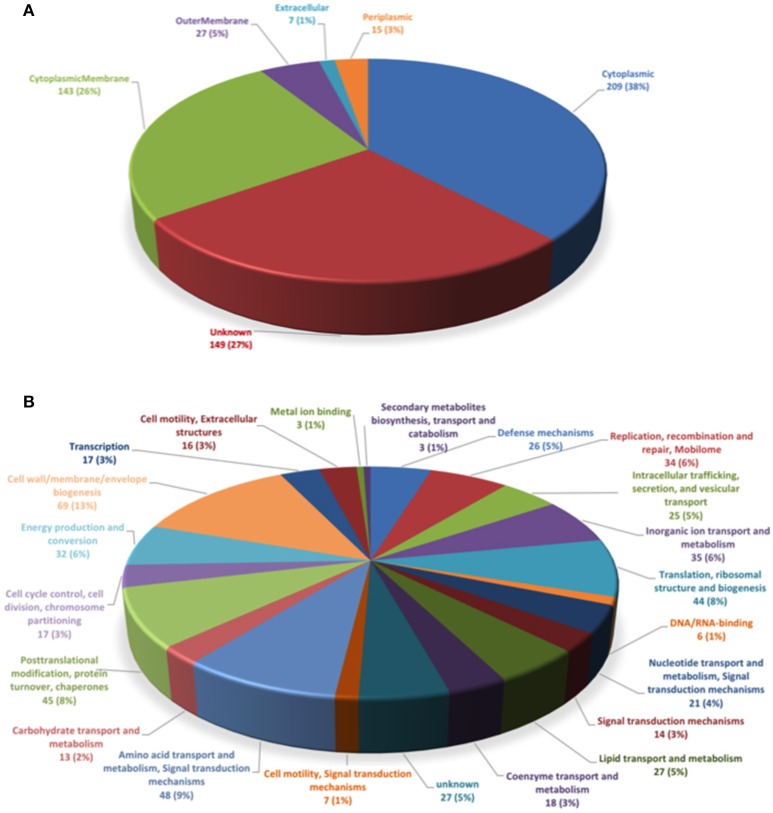
Classification of P. salmonis LF-89 membrane vesicles proteins. (A) Subcellular locations of membrane vesicle proteins identified by MudPIT. Predicted subcellular locations of the 452 membrane vesicle proteins identified using PSORT3b. (B) Functional classification of P. salmonis LF-89 membrane vesicles proteins. The 452 proteins identified by MudPIT were sorted according to the indicated clusters of orthologous groups.